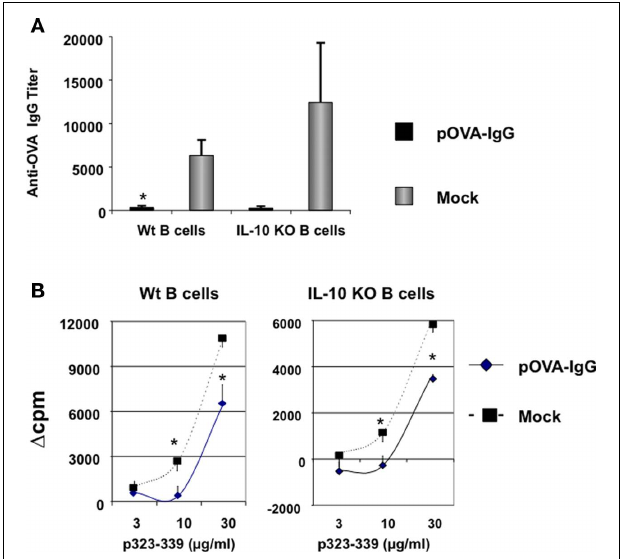
FIGURE 1 | Donor B cells from IL-10 KO mice are tolerogenic. (A) LPS-activated wt or IL-10 KO B cells were transduced with pOVA 323–339 –IgG or a mock control vector (PLP–IgG) and 1 × 10 7 B cells per mouse were injected i.p. into naïve Balb/c recipients. Seven days later, mice were immunized with 25 μ g OVA protein emulsified in CFA via a hind footpad and the base of tail.Two weeks after immunization, sera were collected and assayed for total anti-OVA–IgG by the endpoint ELISA method ( n = 4). (B) Animals were treated as described in Figure 1A . Mice were sacrificed 2weeks after immunization and draining lymph nodes were removed for CD4 + T-cell proliferation assay. Five × 10 5 cells from draining LNs were seeded per well in 96-well plates in the presence of indicated concentrations of p323–339. After 48h, cultures were pulsed with 1 μ Ci/well of [ 3 H] thymidine (Amersham Life Sciences, Arlington Heights, IL, USA) and incubated for another 16–20h. Cells were then harvested on glass fiber filters andT-cell proliferation to p323–339 was determined by [ 3 H] thymidine incorporation.Values represent mean (cid:2) cpm (count per minute by subtraction of the background) ± SE for four animals. Data are representative of two independent experiments.